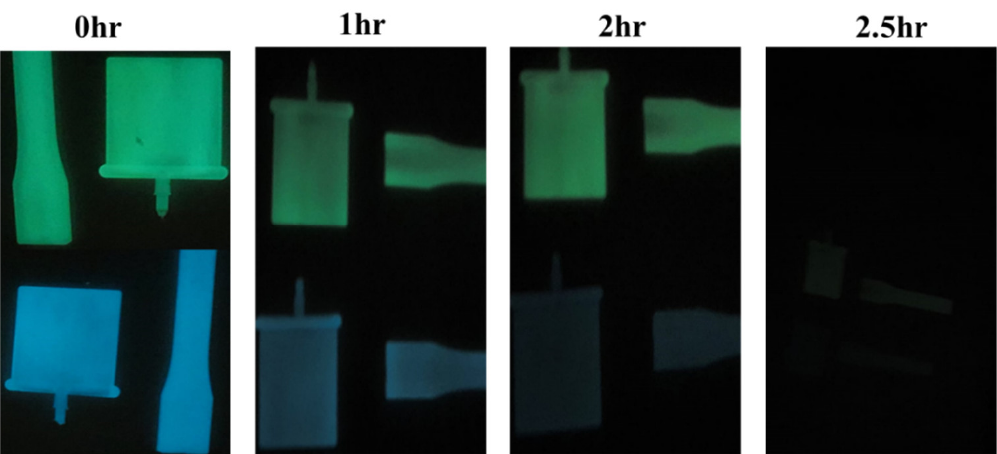
Figure 7. The green and blue emission decay at different times for PP/5PRIEX/10SAO 1 and blue PP/5PRIEX/10 SAO 2 composites (after excited in outside sunlight for 10 min and kept in a dark Figure 6. The phosphorescence emission spectra of PP/5PRIEX/SAO 1 ( A ) and PP/5PRIEX / SAO 2 ( B ) composites.